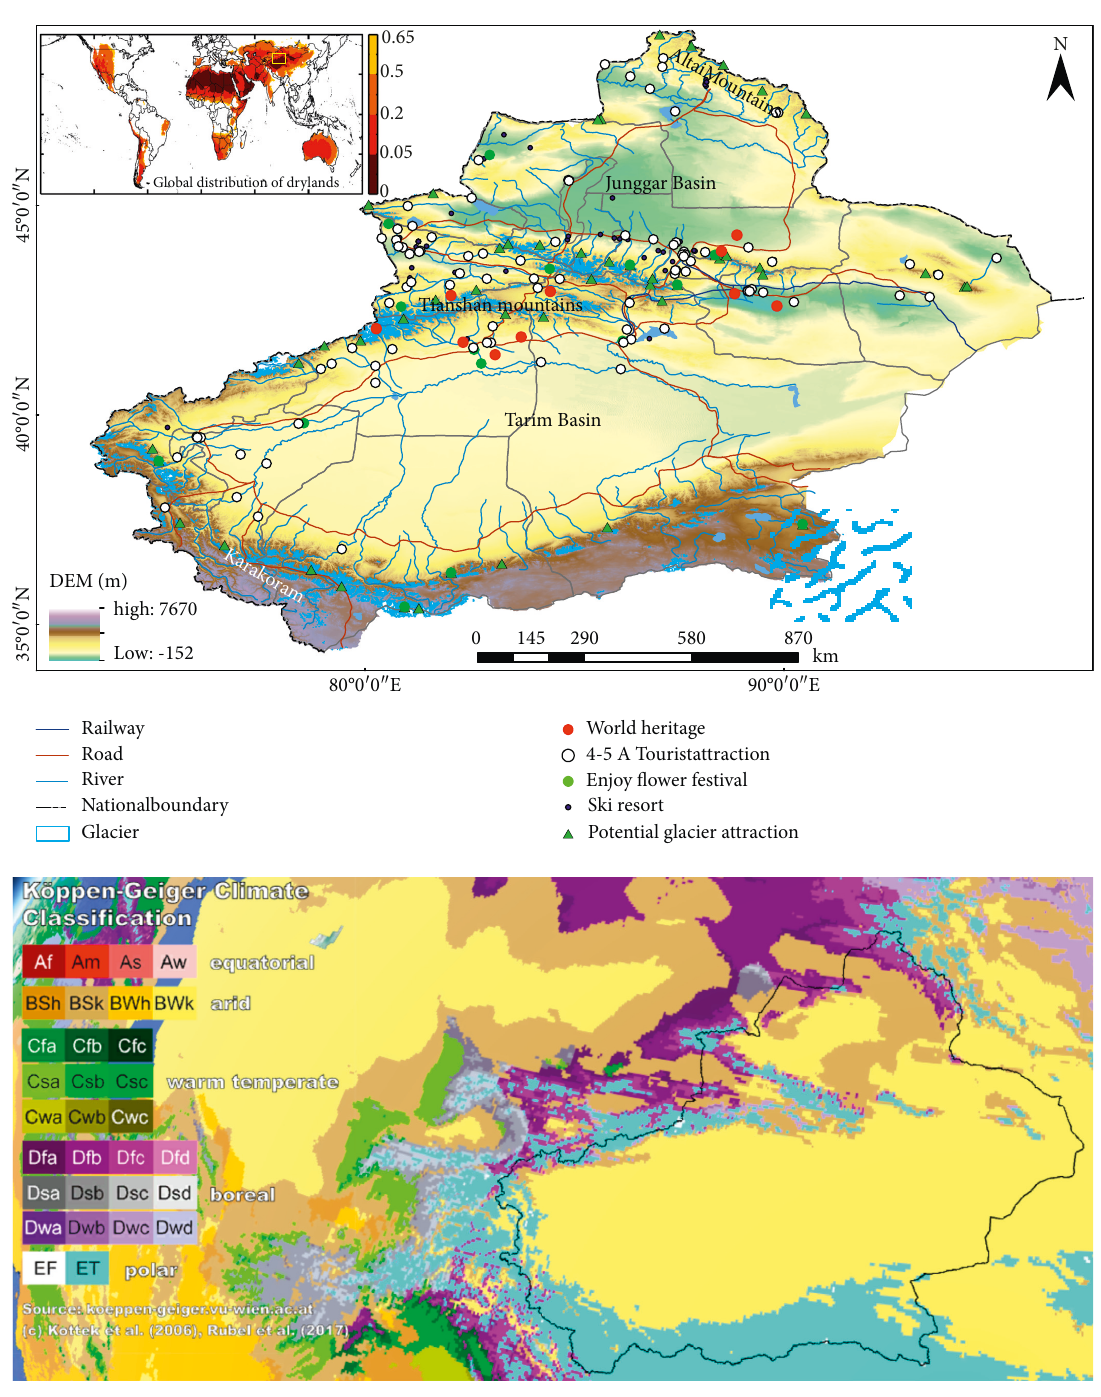
Figure 1: Geomorphic features (above) and climate classification (blow) of the